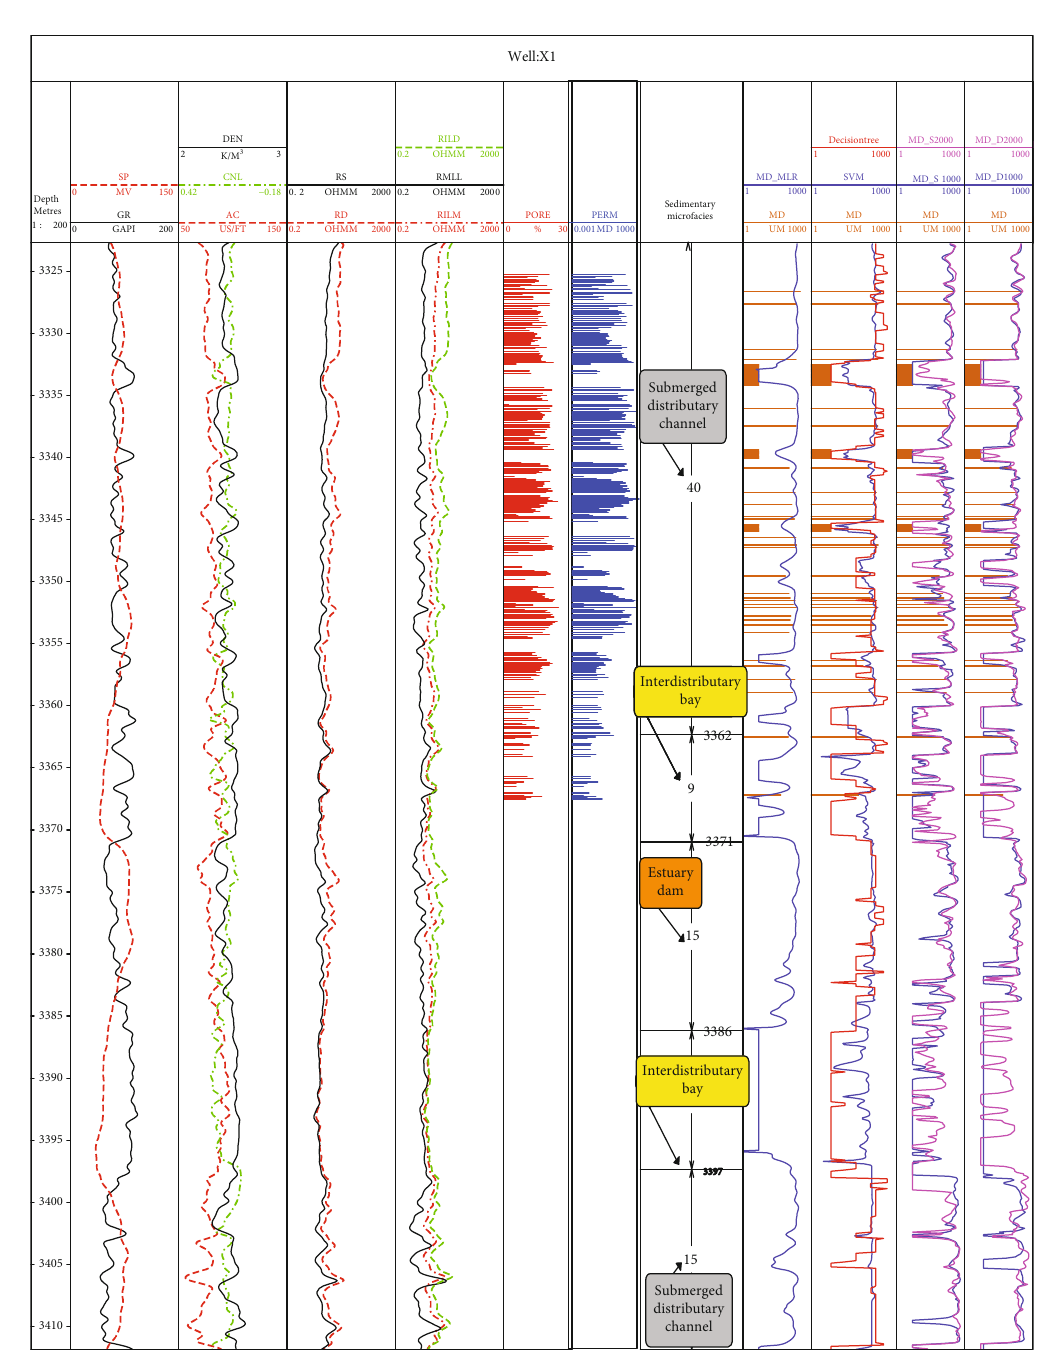
section of well 2